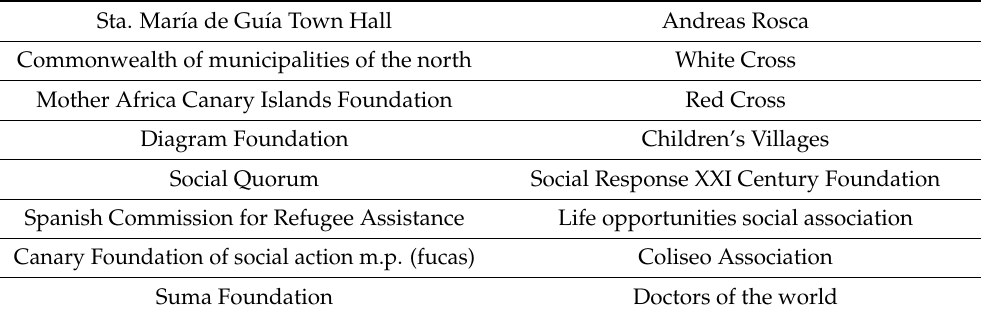
Table 1. Institutions/organizations having an agreement with the